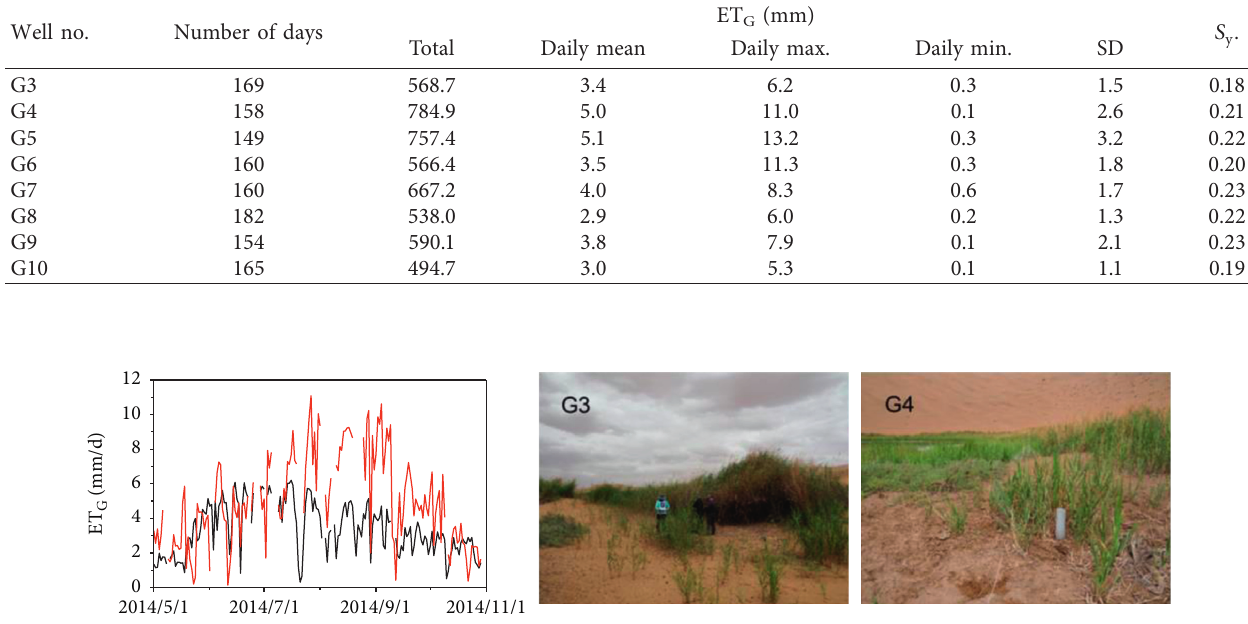
G ) of observation sites during the growing season in 2014, number of ET G (mm) Total Daily